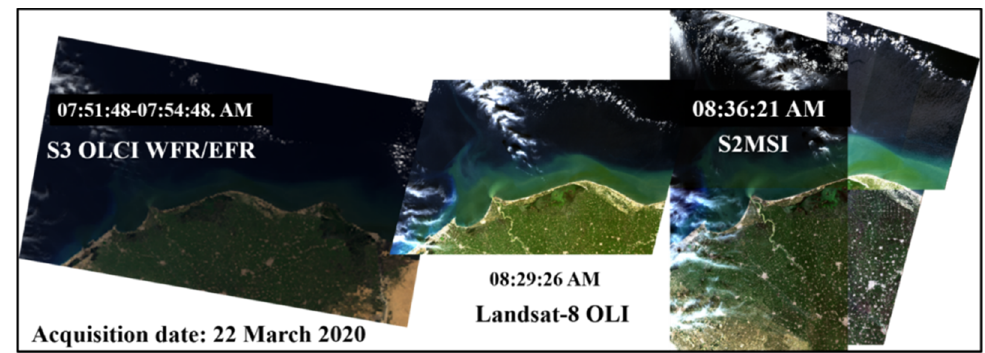
Figure 2. Natural color image over the Nile Delta of the Sentinel-3 OCLI WFR/EFR, Landsat-8 OLI, and Sentinel-2 MSI varying in the sensed time of 45 min over the Nile Delta Coast of Egypt. Table 1. Remote Sensing data acquired over North of the Nile Delta of Egypt.